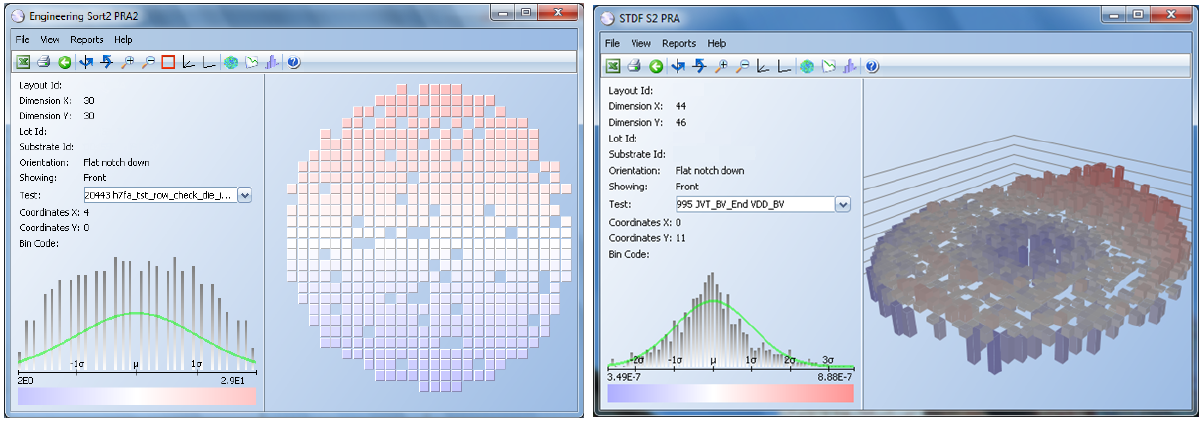
Figure 9. Dynamic Part Average Testing (DPAT) examples 2D and 3D wafer